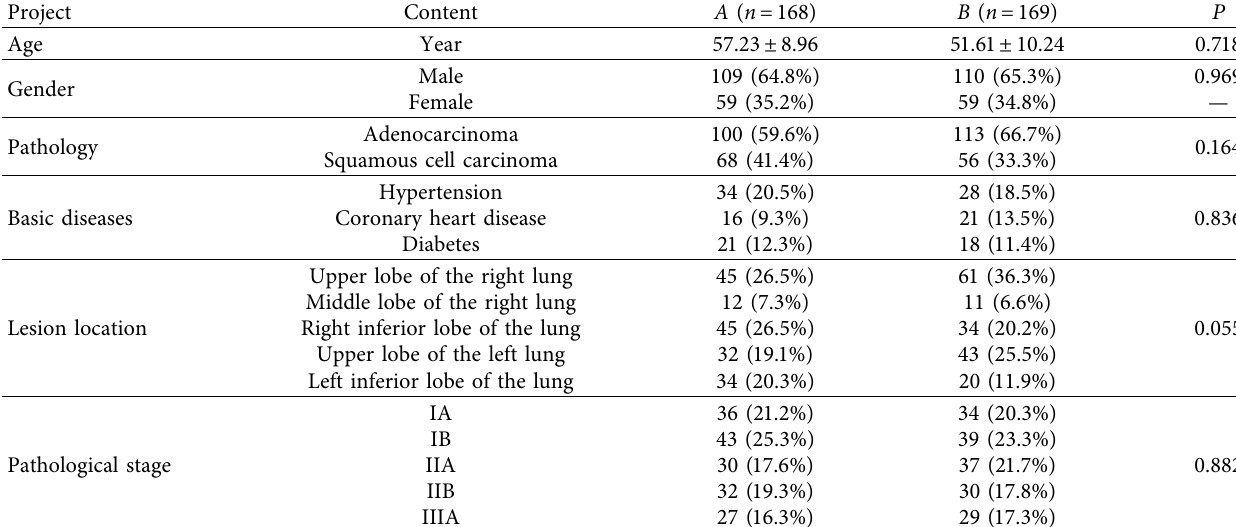
Table 2: Comparison of general data of